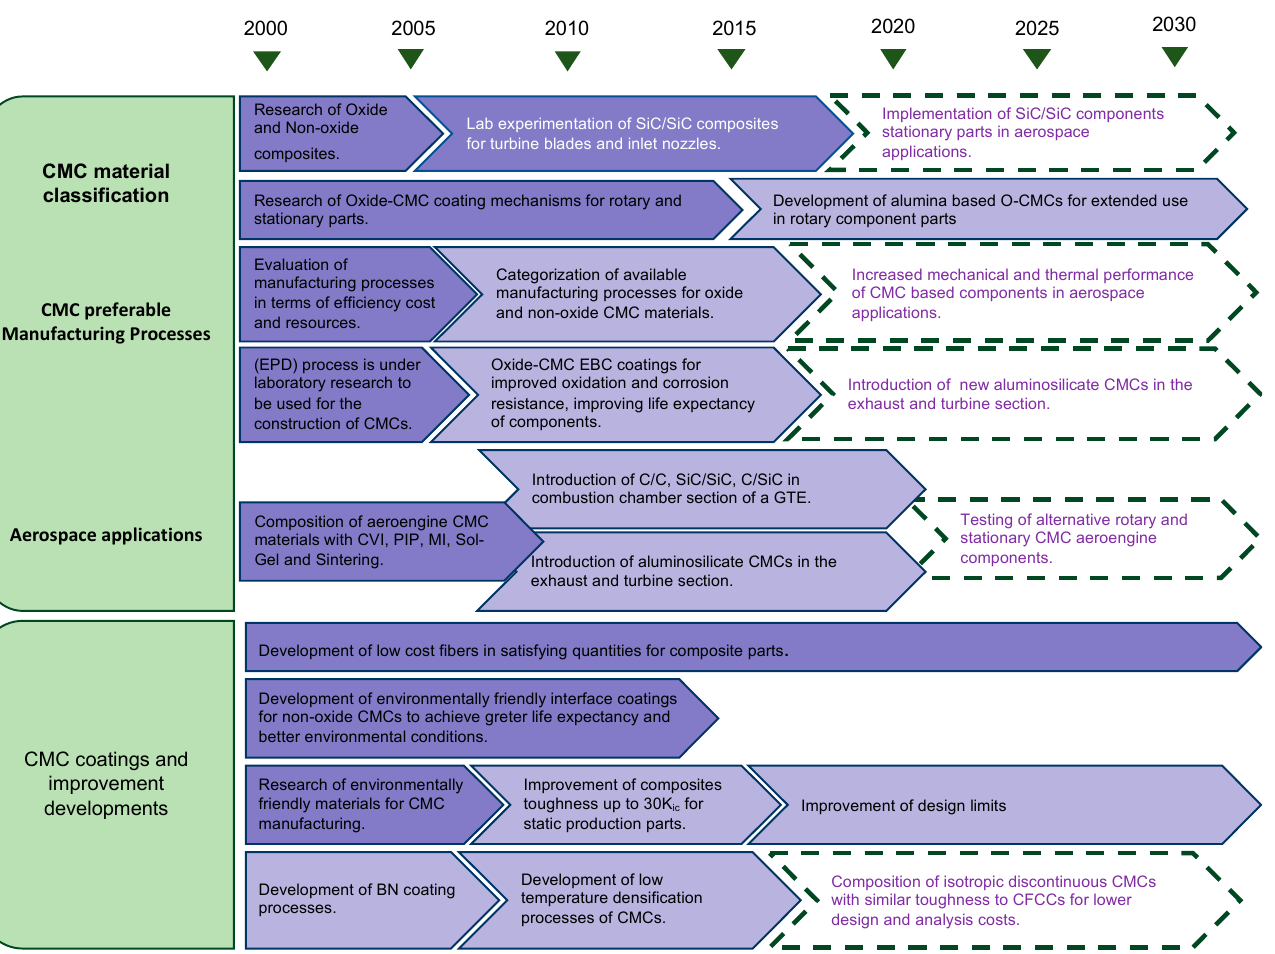
Figure 21. CMC materials, coatings, and manufacturing processes for aero-engine applications Roadmap (the same key as Figure 20 applies).